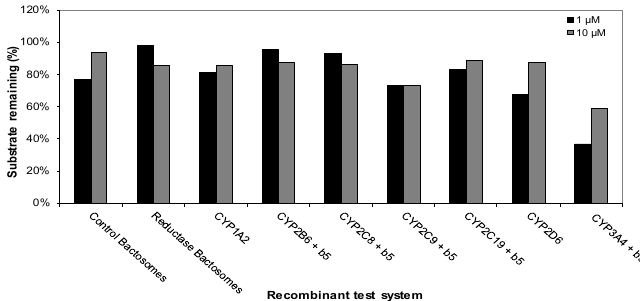
Figure 2. Metabolism of CRV431 (1 and 10 μ M) by a panel of recombinant human CYP enzymes (50 pmol/mL).